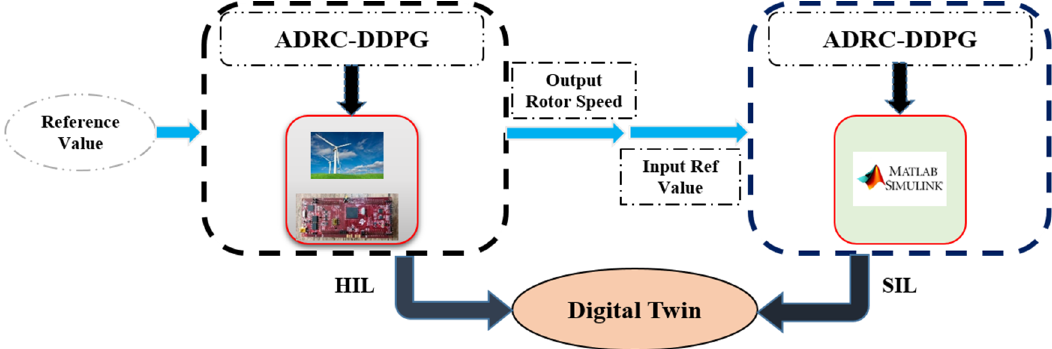
Figure 3. A proposed strategy for the combination of hardware-in-loop (HIL) and software-in-loop (SIL) testing.